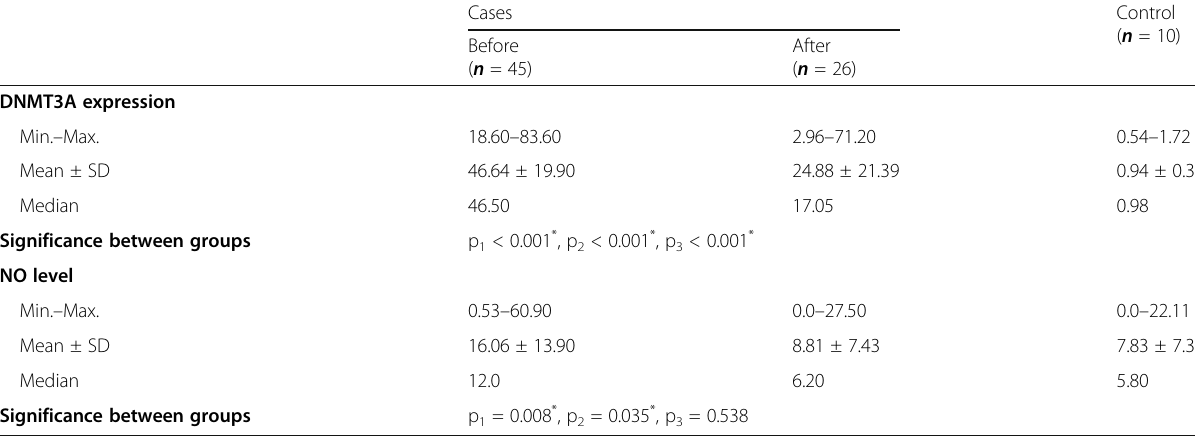
Table 2 Comparison between the two studied groups according to DNMT3A expression and NO level before and after treatment